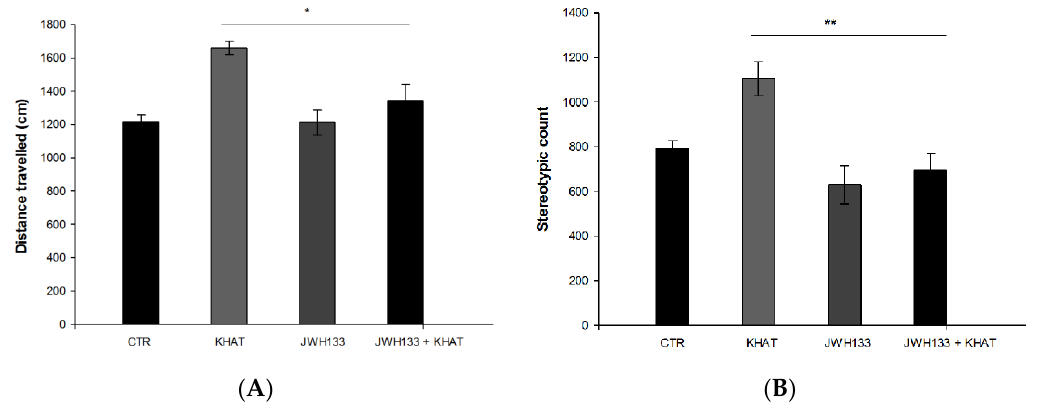
Figure 3. Effect of co-administration of the CB2R agonist JWH133 on khat extract induced increase in locomotor activity in wild type (WT) mice. ( A ) Effect of co-administration of the CB2R agonist JWH133 on khat extract induced increment in distance travelled (centimeters) in the activity box. ( B ) Effect of co-administration of the CB2R agonist JWH133 on khat extract induced increment in stereotypic count in the activity box. Values are mean ± SEM (n = 6 in each group). Statistical analysis was done using one-way ANOVA followed by Tukey ′ s multiple comparison test. ** p < 0.01, * p < 0.05. CTR (control group received the vehicle), KHAT (treatment group received khat extract in a dose of 300 mg/kg), JWH133 (treatment group received JWH133 in a dose of 5 mg/kg) and JWH133/KHAT (treatment group received khat extract 300 mg/kg in combination with JWH133 5 mg/kg). The vehicle, khat extract, and JWH133 were administered to mice once daily for seven consecutive days.